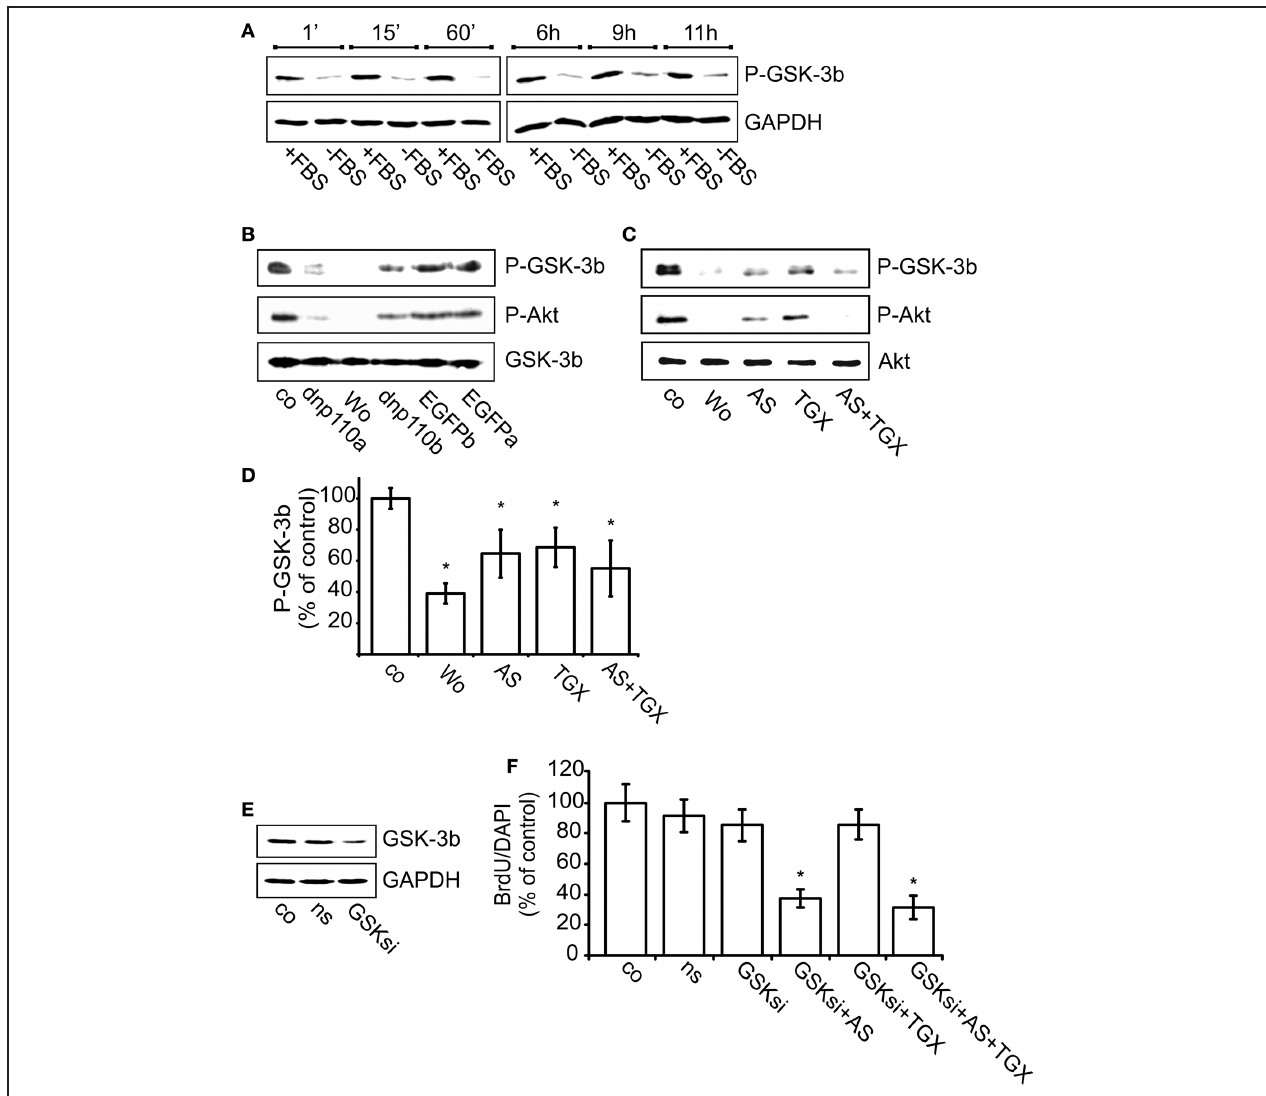
FIGURE 5 | Inhibition of p110 β decreases the phosphorylation of GSK-3 β and thereby reduces BrdU uptake. (A) Upper lane: time-course of GSK-3 β phosphorylation (P-GSK-3 β ) after FBS removal for 24 + n h (–FBS) as well as after re-addition of FBS for n h ( + FBS). GAPDH served as input control (lower lane). (B) Upper lane: effects of dnp110 α K802R (dnp110 α ) and p110 β K805R (dnp110 β ) on the phosphorylation of GSK-3 β . After prior FBS withdrawal, 10% FBS was added for 8h. Vehicle-treated controls (co); controls for dnp110 α K802R ∼ EGFP α ; controls for p110 β K805R ∼ EGFP β Wortmannin (100nM, wo) was added together with FBS. Middle lane: P-Akt in lysates of the same cells. Lower lane: total GSK-3 β served as input control.